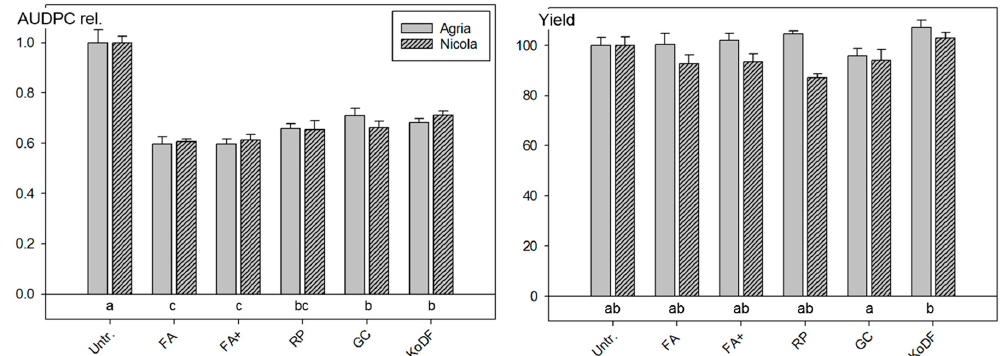
Figure 2. Field experiment in 2010 at Tänikon with the two potato varieties Agria and Nicola: Effect of suspensions of botanical powders of Frangula alnus (FA & FA+), Rheum palmatum (RP) and Galla chinensis (GC), as well as the copper fungicide Kocide DF (KoDF) on foliar blight (relative AUDPC) and the potato tuber yield (%). Treatments are described in Table 2. Untr. = Untreated control. Bars: Mean values of the varieties and standard errors of the means. AUDPC rel.: Area under the disease progress curve relative to the untreated control. Treatments labelled with the same letter are statistically not different (Tukey test p < 0.05).